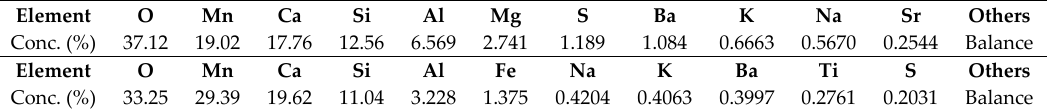
Table 1. Chemical composition of the slags (above silicomanganese, and below ferromanganese).